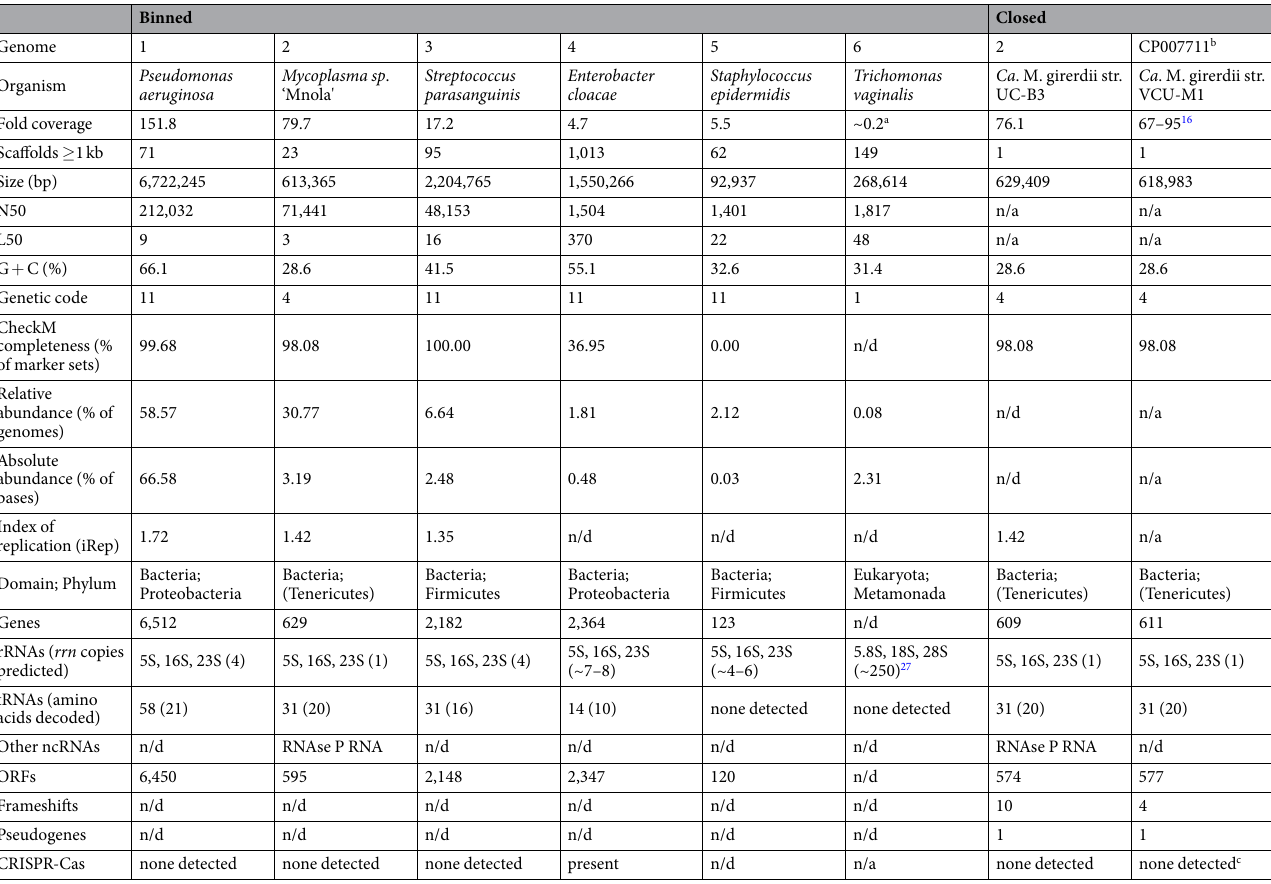
Table 1. Genomes reconstructed from the oral metagenome of a 3-week-old premature infant. a Estimated using reference-based mapping; b Accession number of the vaginal strain, provided here for reference; c Our own finding, which differs from that of Fettweis et al . 16 as described in the Supplementary Methods; n/a, not applicable; n/d, not determined; (Tenericutes) branches within the phylum Firmicutes 7